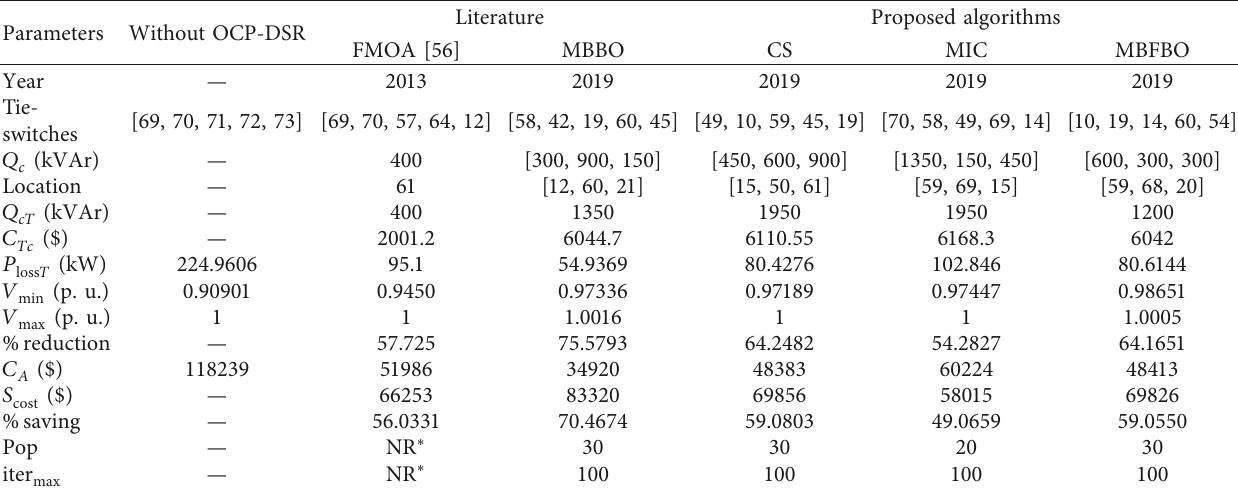
Table 11: Results and comparisons of IEEE 69-bus RDS without and with dual OCP-DSR